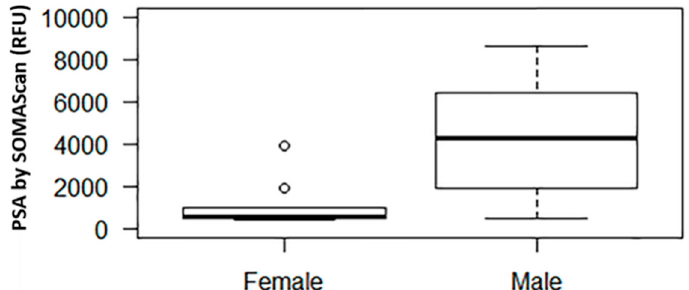
Figure 1. Relative fluorescence unit (RFU) signal of prostate specific antigen (PSA) by SOMAscan in males vs. females. The middle horizontal line represents the median. The box bounds the 25th and 75th percentile of the points. The dotted lines connect to the thin horizontal line denoting 1.5 interquartile range (IQR) from the median. The dots denote points with values outside of the 1.5 IQR from the median.